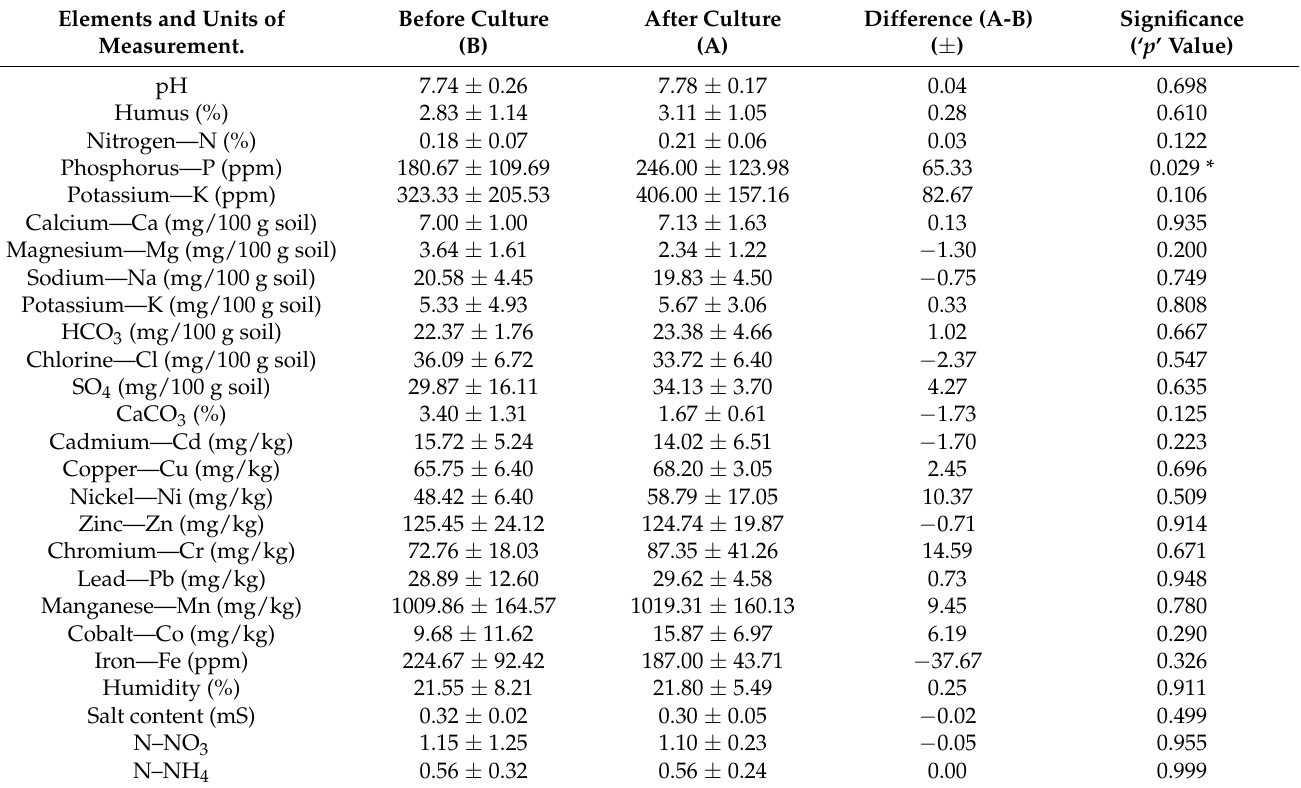
Table 2. Changes in the soil components between the two periods: A, after culture (after the clearing of plants at the final harvest and end of crop); and B, before culture (at the planting seedlings and start of the culture). The results are the average values ± SD (standard deviation) of the three treatments (T1, T2,